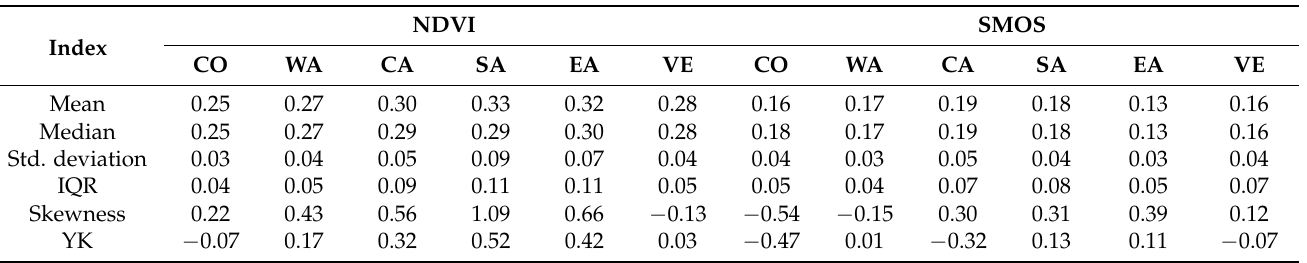
Table 3. Analysis of location (mean and median), dispersion (standard deviation) and symmetry indices for NDVI and SMOS in the six studied